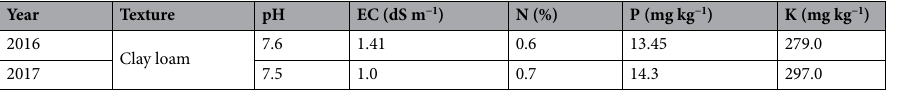
Table 2. Some soil properties of the experimental field before beginning the study (0–30 cm).